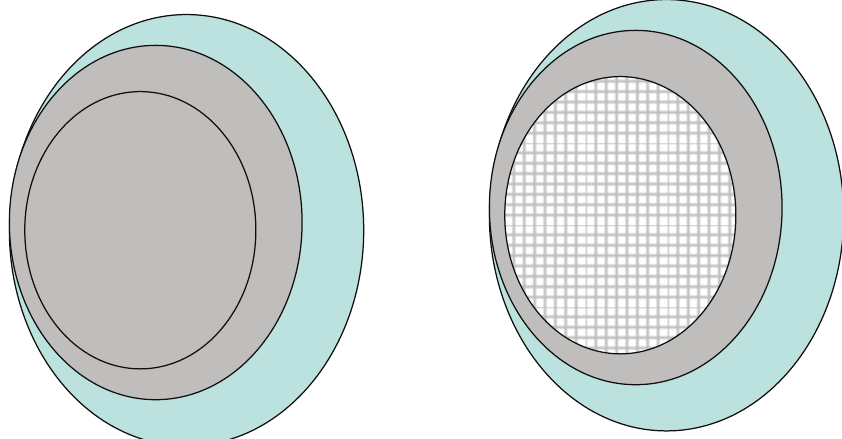
Figure 1: Schematic representation of a microsphere and a microcapsule. In microspheres, the whole particle consists of a continuous polymer network. Microcapsules present a core-shell structure with a liquid core surrounded by a polymer shell.